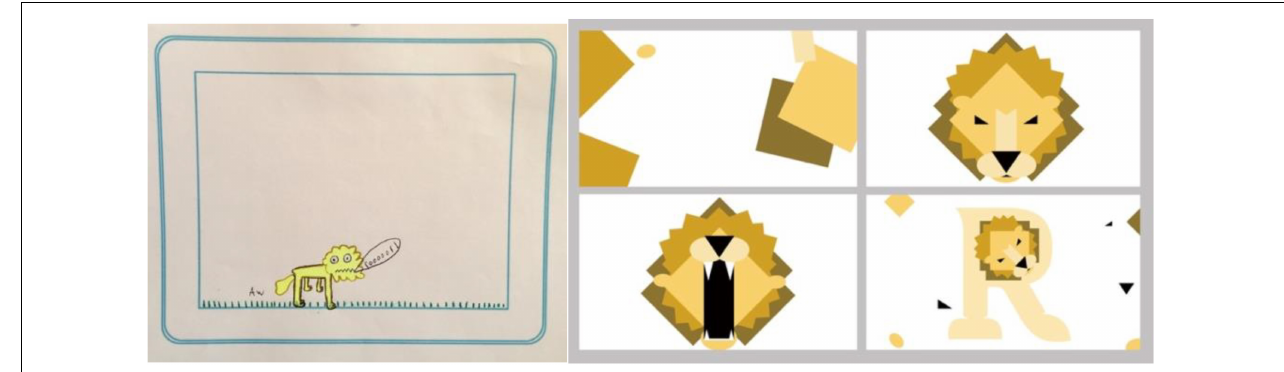
FIGURE 8 | A child’s animation during User Study 1; an image of a lion roaring (left) and stills from the final animation for the letter R titled “R is for Roar” (right) .